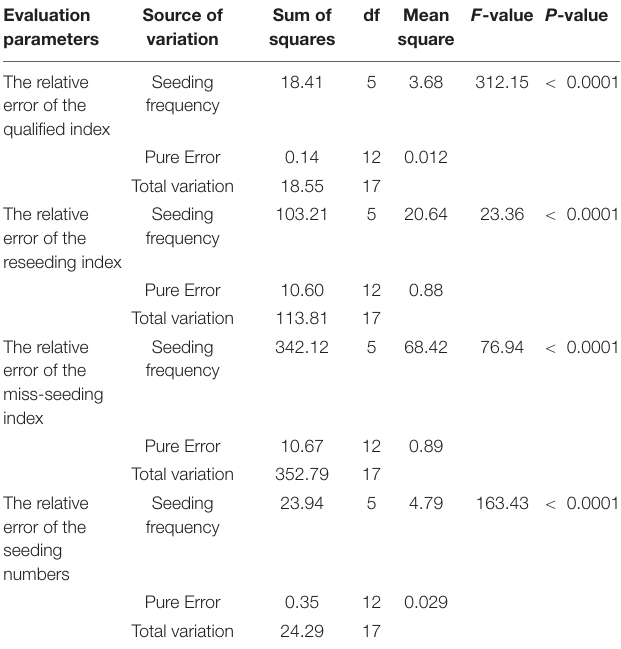
TABLE 4 | Analysis of seeding frequency variance based on the evaluation parameters. Evaluation Source of parameters variation